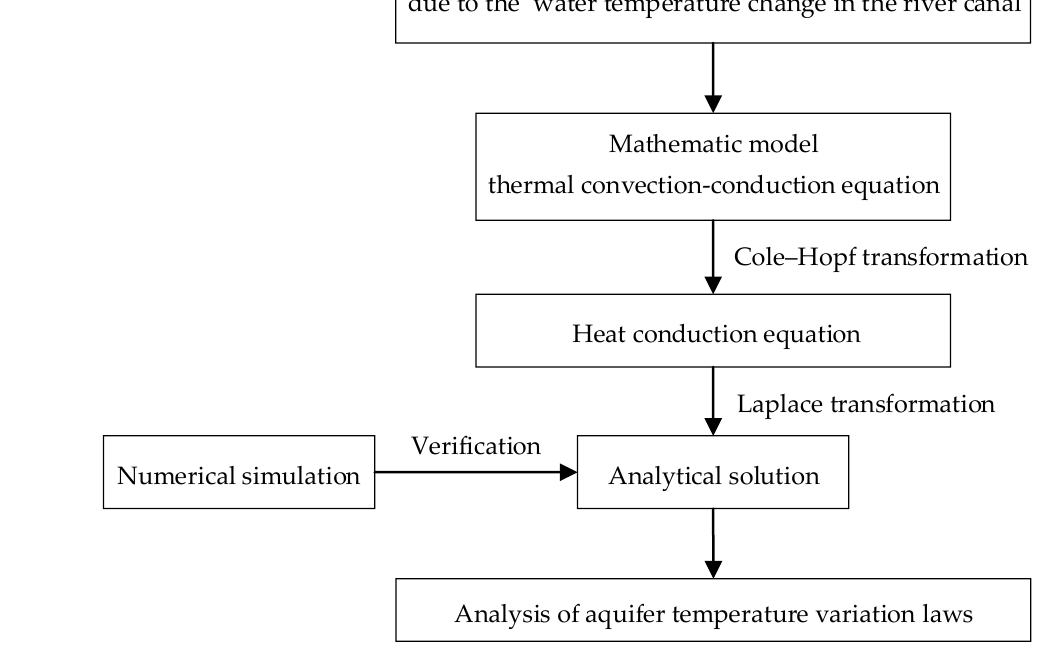
Figure 1. Flowchart of the research methodology.